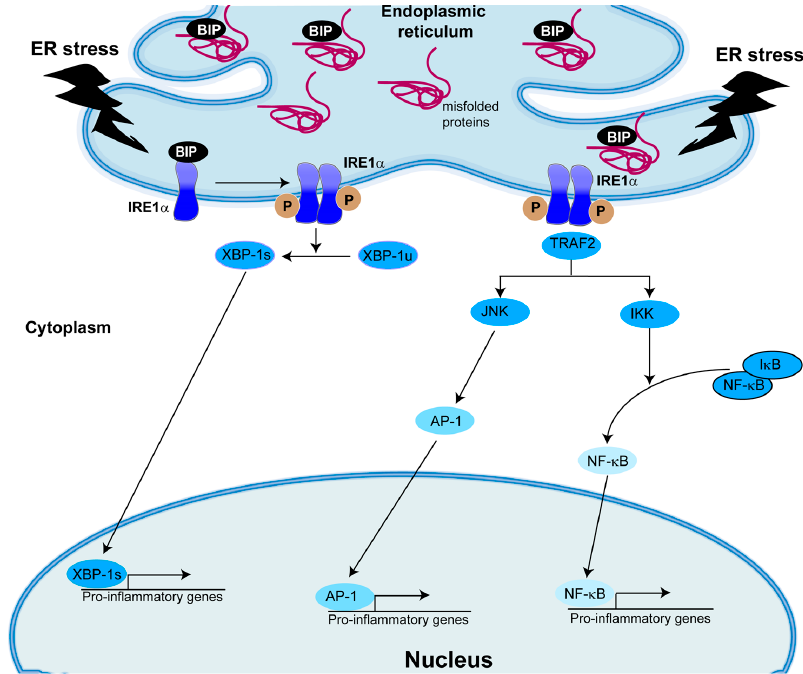
Figure 2. IRE1 α -dependent inflammatory signaling pathways. During ER stress, activation of IRE1